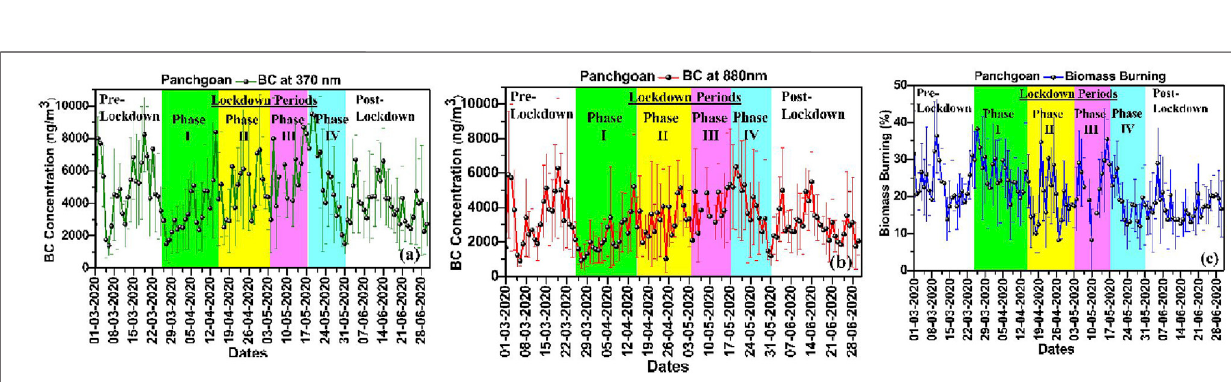
Frontiers in Environmental Science |